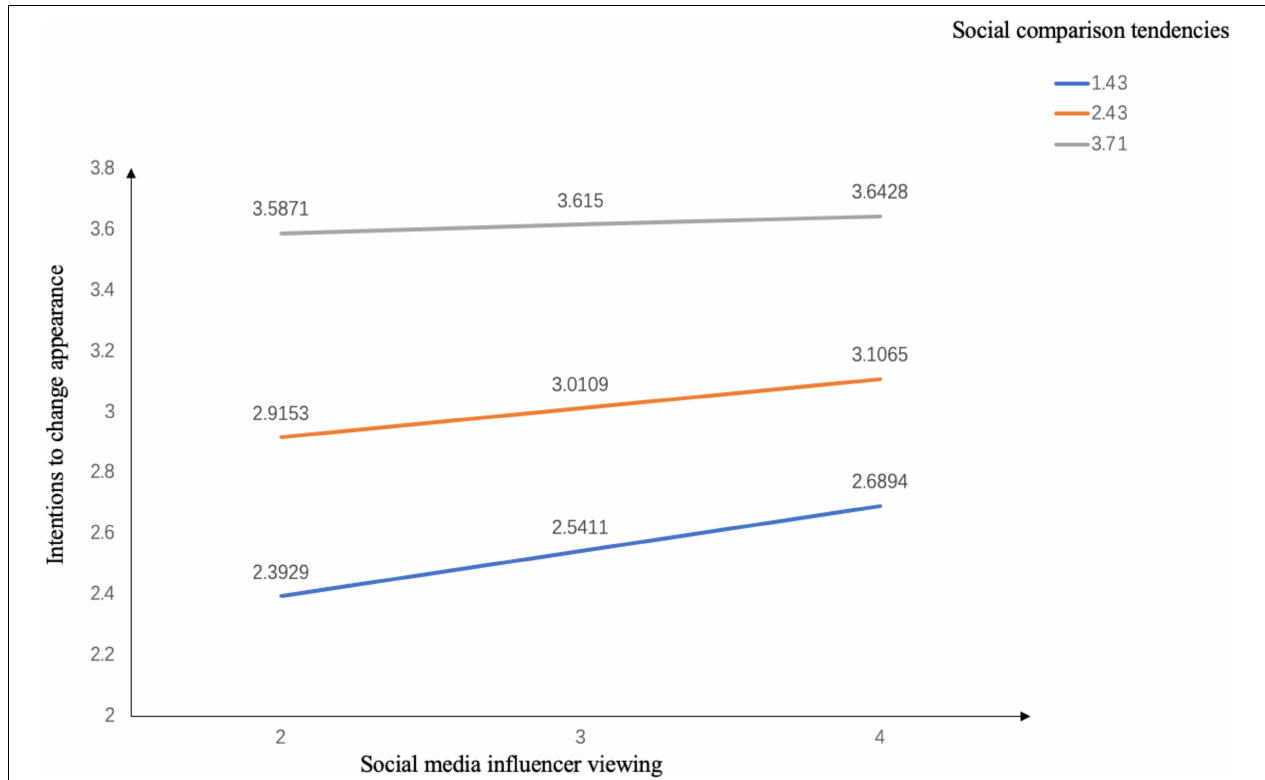
FIGURE 2 | Social comparison tendencies moderating the association between social media influencer viewing and intentions to change